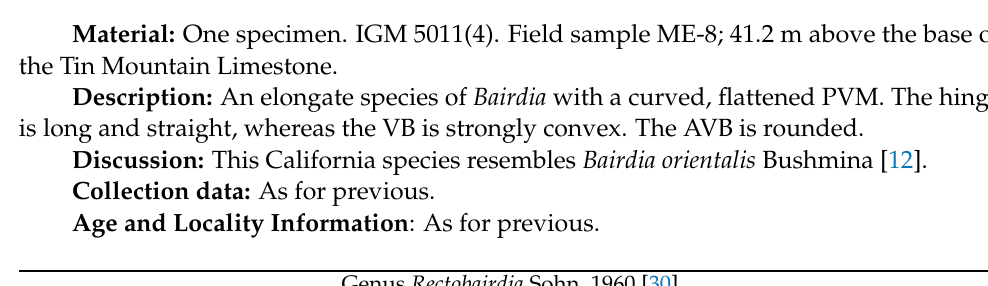
Figure 7. Bairdia sp. cf. B. orientalis Bushmina, 1975, right valve, lateral view. IGM 5011(4). Scanning electron micrograph (secondary electrons). Scale bar = 50 microns.